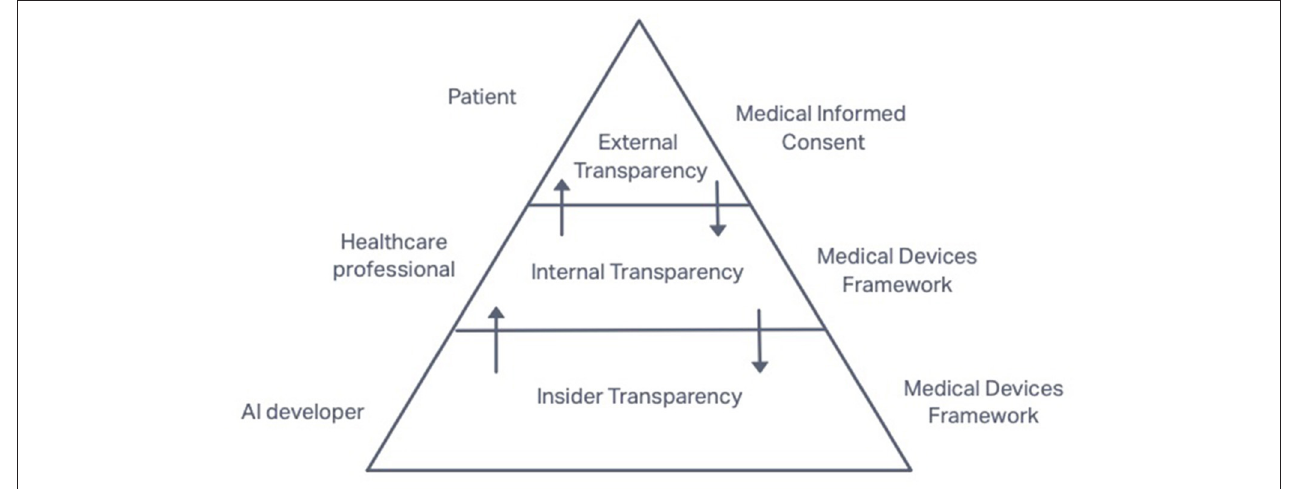
FIGURE 3 | Multilayered System of AI’s Transparency in